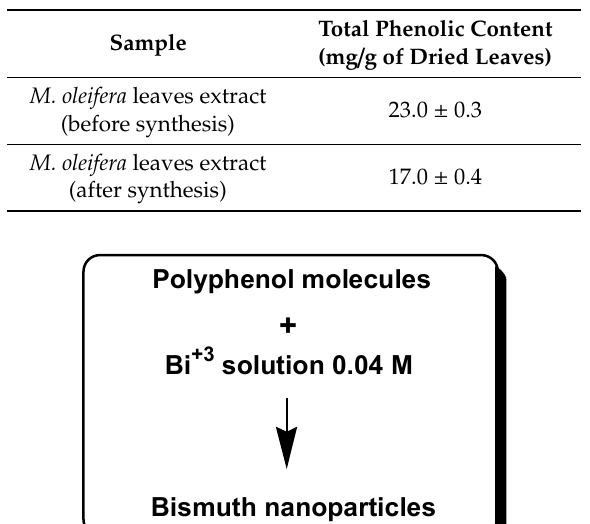
Table 2. Determination of total phenolic content before and after the synthesis of bismuth